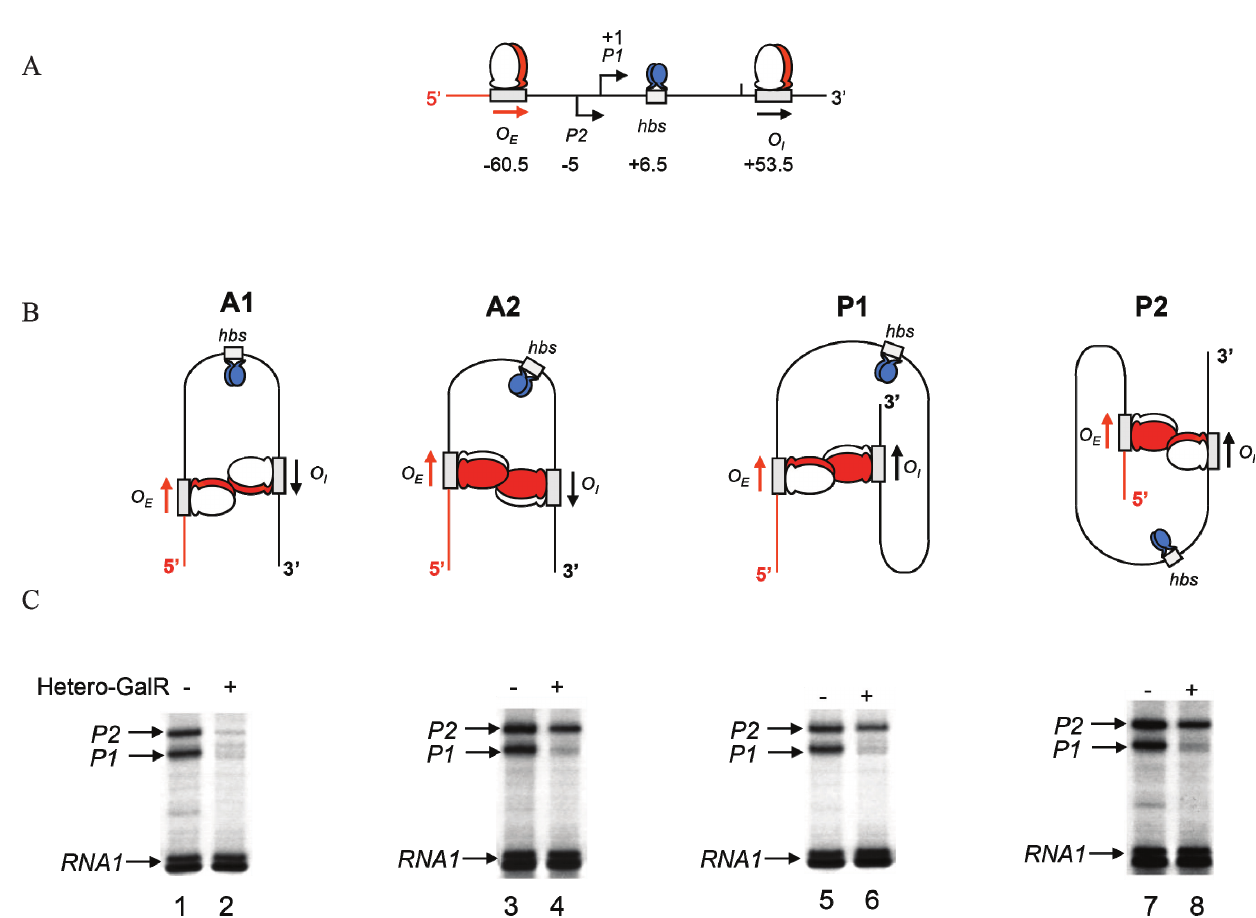
Figure 15. Trajectory of DNA loops formed by GalR and HU; ( A ) The gal regulatory region containing promoters ( P1 and P2 ), operators ( O E and O I ), HU binding site ( hbs ). The arrows at O E and O I are shown in the direction 5' to 3'; ( B ) Two trajectories of DNA loops, “antiparallel” (A), and “parallel” (P); ( C ) mRNAs made from P1 and P2 in